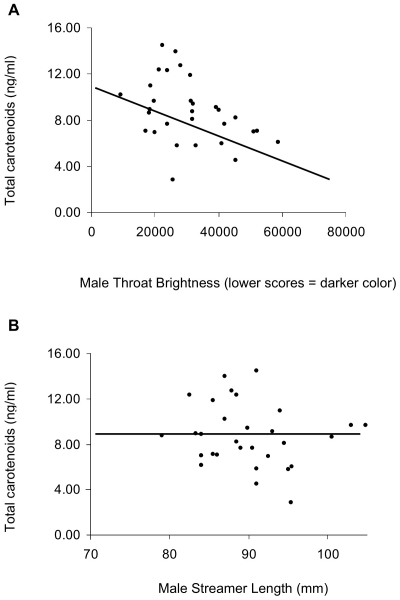
Circulating carotenoids are correlated with feather color, not tail streamer length.Variation in A) throat color, not B) streamer length, predicts variation in circulating carotenoid in male (shown) and female (similar trends not shown) barn swallows sampled at the beginning of the breeding season. N = 71 individuals.